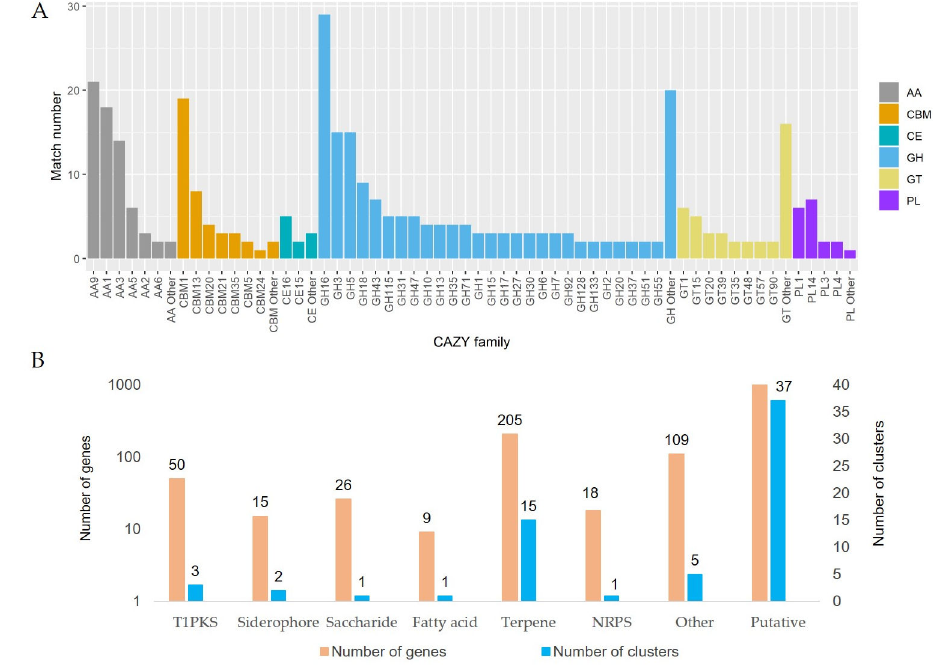
Figure 3. ( A ) Annotation of carbohydrate-related genes in the G. incarnatum genome; ( B ) secondary metabolite-related gene clusters in the G. incarnatum genome. T1PK: Type I polyketide synthases; NRPS: nonribosomal peptide